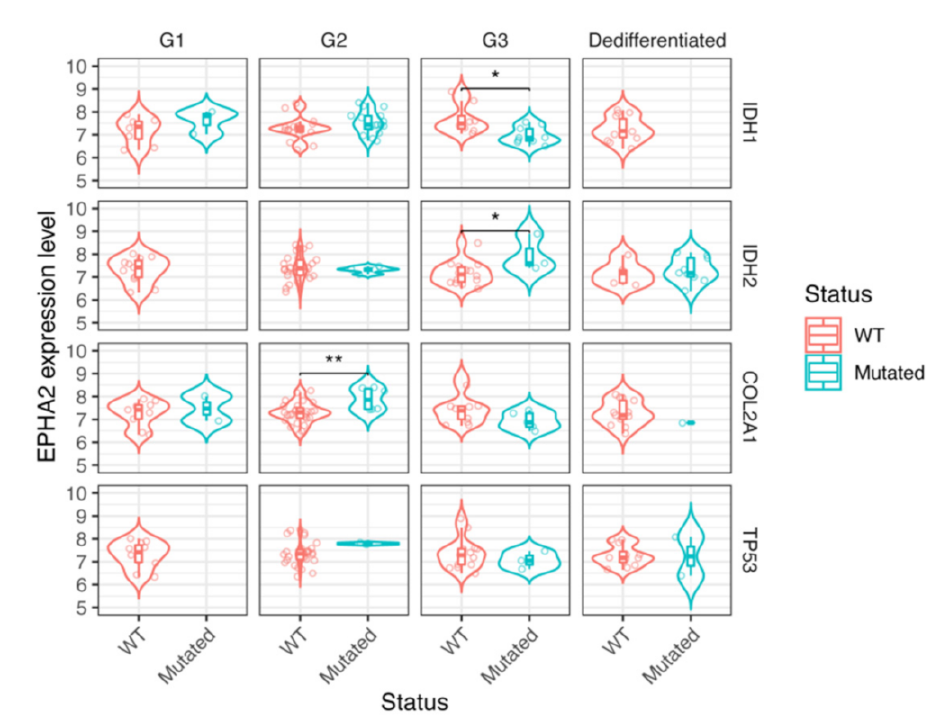
Figure 5. Boxplot showing association between chondrosarcoma mutational status and EPHA2 expression across different chondrosarcoma subtypes. The selected subtypes were dedifferentiated chondrosarcomas ( n = 16), G1 chondrosarcomas ( n = 17), G2 chondrosarcomas ( n = 38) and G3 chondrosarcomas ( n = 17) * p < 0.05; ** p <